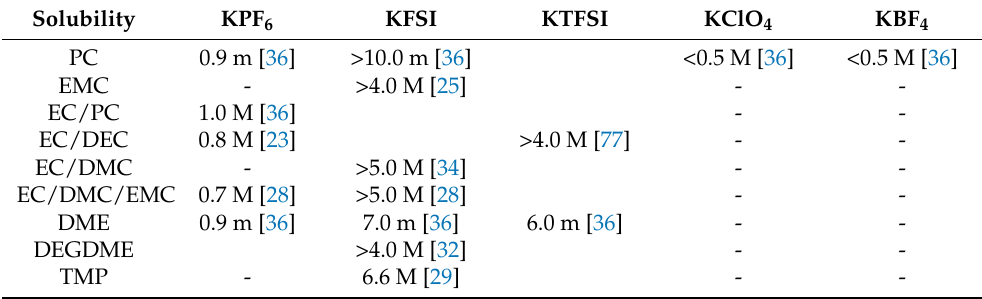
Table 3. Solubility (M (mol/L)/m (mol/kg) at 25 ◦ C) of most used potassium salts in typical